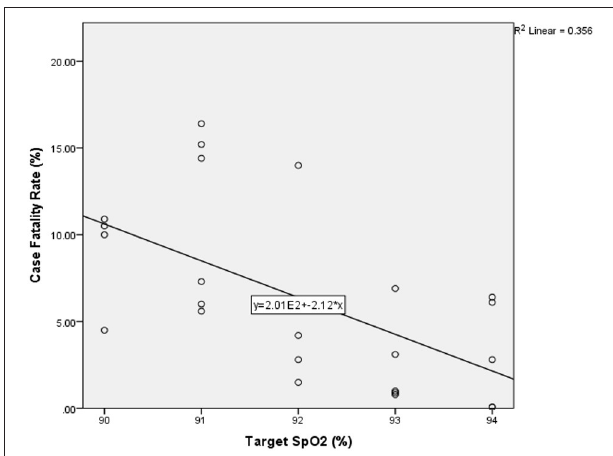
FIGURE 2 | Scatter graph of national target oxygen saturations vs. national case fatality rate with best fit linear line ( n = 26). SpO 2 –oxygen saturations.